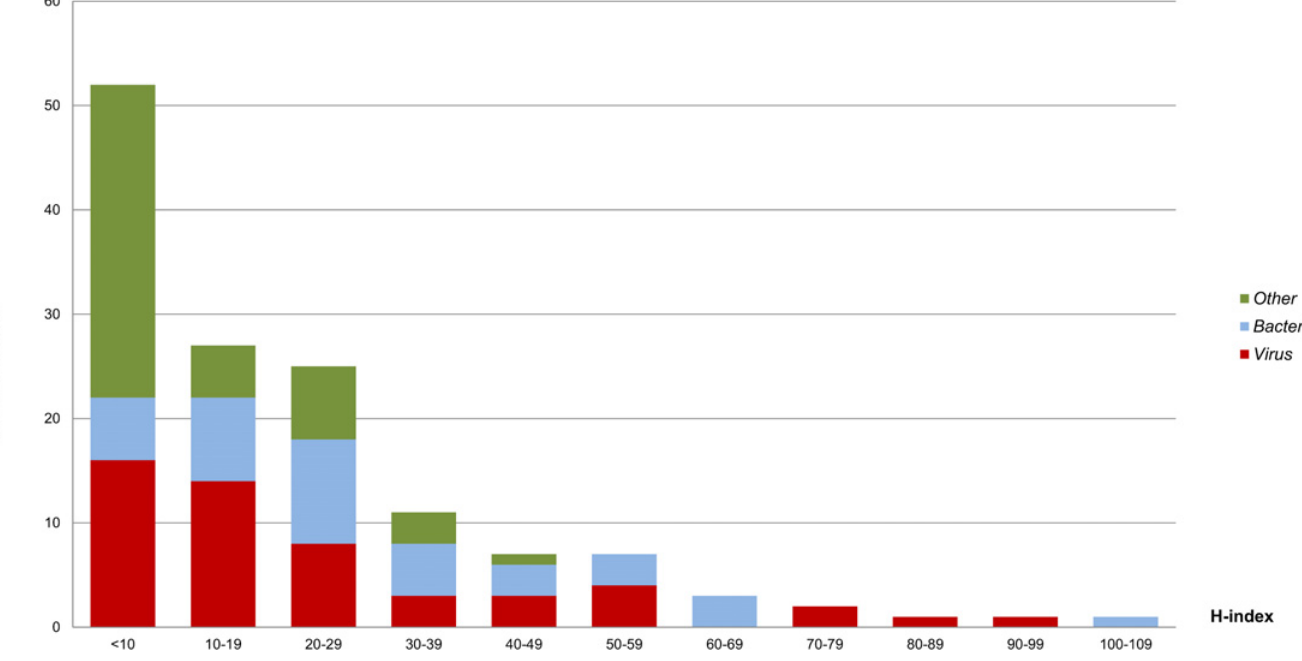
Fig 1. Frequency histogram. Frequency of the H-index scores for pig infectious agents according to taxonomic groups: Virus , Bacteria and Other (Helminthes, protozoa, external parasites and fungi).